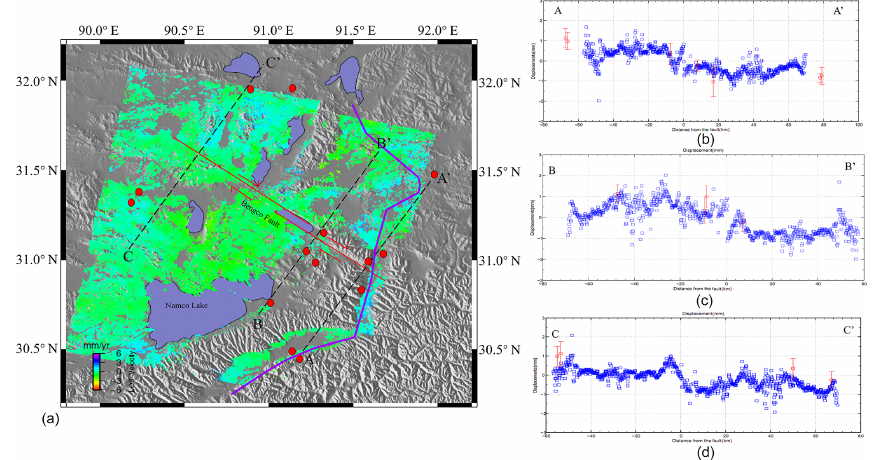
Figure 11. Bengco fault slip rate. The red line shows the Bengco fault. The purple line shows the railway. The red circle shows the GPS location. The black dotted line shows the profiles of the Bengco fault. The purple line shows the highway. The left figure shows the Bengco fault slip rate. The right figure shows the detailed information on